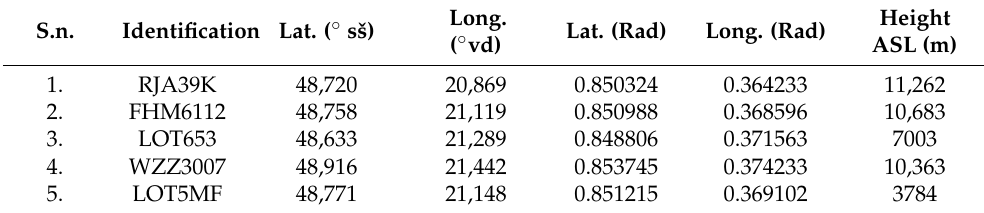
Table 1. Initial coordinates of users by flightradar24.